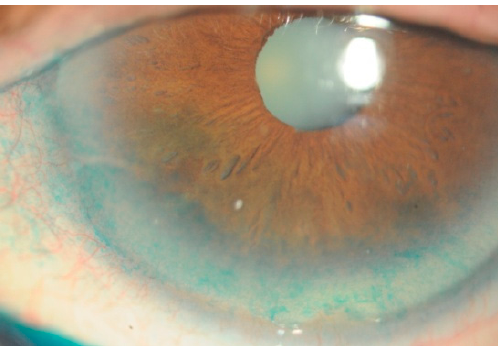
Figure 3. Dry-eye syndrome is a multifactorial disease of the ocular surface in which oxidative stress is greatly involved. Affected patents suffer from symptoms of discomfort and tear film instability, and visual quality is reduced proportionally to the severity of the disease. The Figure 3 shows an example of corneal epithelium injuries in a patient affected by dry-eye syndrome, as detected by means of Lissamine green staining. Diffuse corneal epithelium alterations appear as green dots in the frame-shift of the inferior cornea surface.